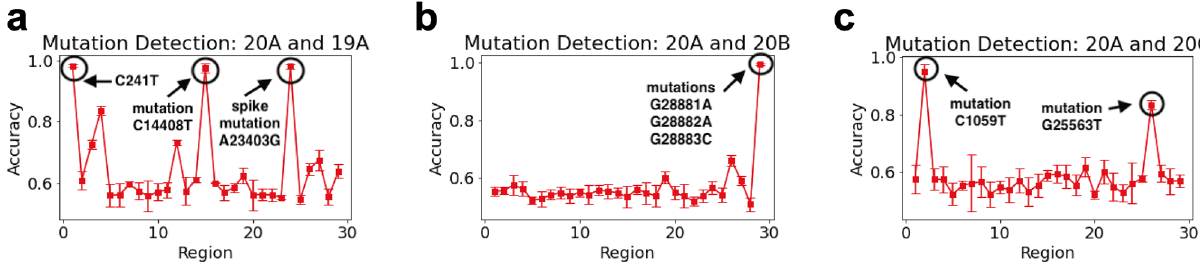
Figure 6. Mutation region detection in SARS-CoV-2 clades. Here, we show how the state machine model can be used to detect the mutations differentiating various clades without the need for sequence alignment. In this method, we divide each SARS-CoV-2 RNA sequence into 30 regions of length 1000 each and calculate the classification accuracy for the model comparing the transition probability matrix calculated for each 1000 length region. The regions for which the classification accuracy is high are the spots where the transition probability matrices are different due to mutations occurring in that region. For example, an accuracy of 1 in region 24 (23000–24000) in ( a ) indicates the detection of spike protein mutation (A23403G or D614G) in nextstrain clade 20A when compared against 19A. Further in plots ( b , c ), we detect regions with mutations differentiating clade 20A with 20B and